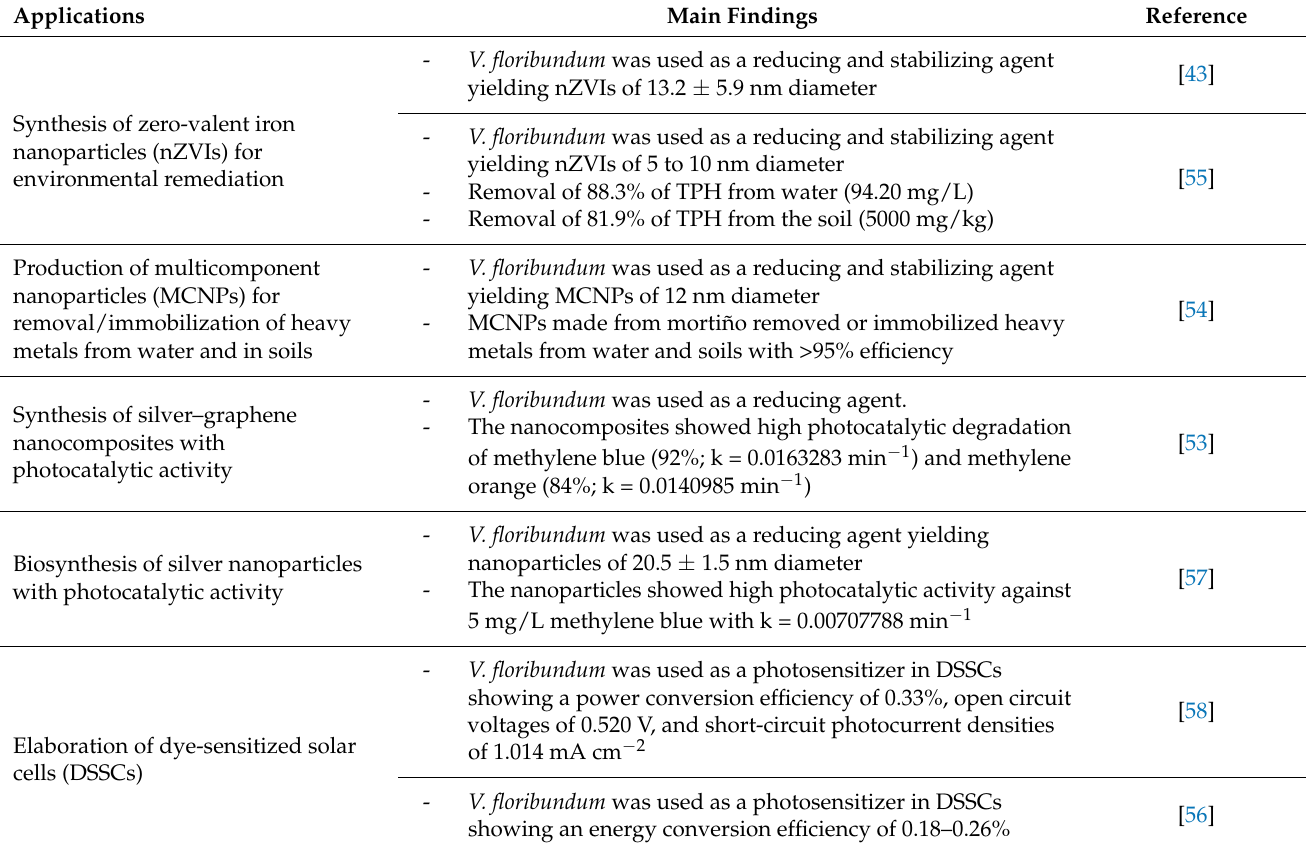
Table 4. Other applications of Vaccinium floribundum